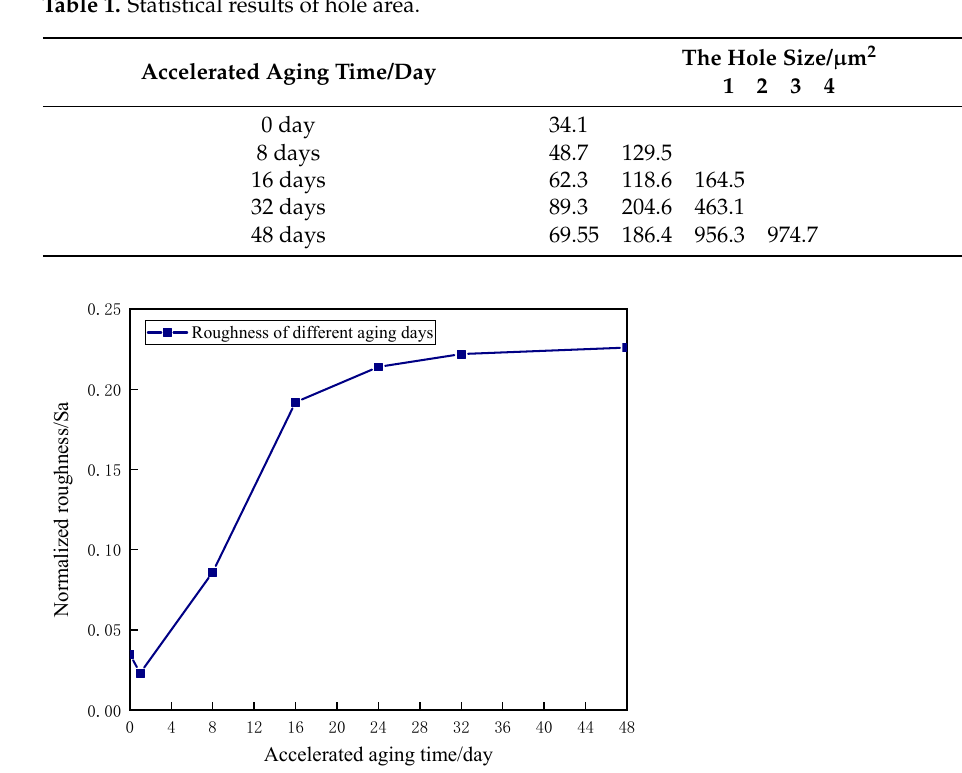
Figure 7. The trend of the various parameters during the aging process. The degree of polymerization of the insulating board reflects its aging degree, so the degree of polymerization of the insulating board is taken as the statistic to evaluate the aging degree of the insulating board. As can be seen from Figure 7, when the degree of